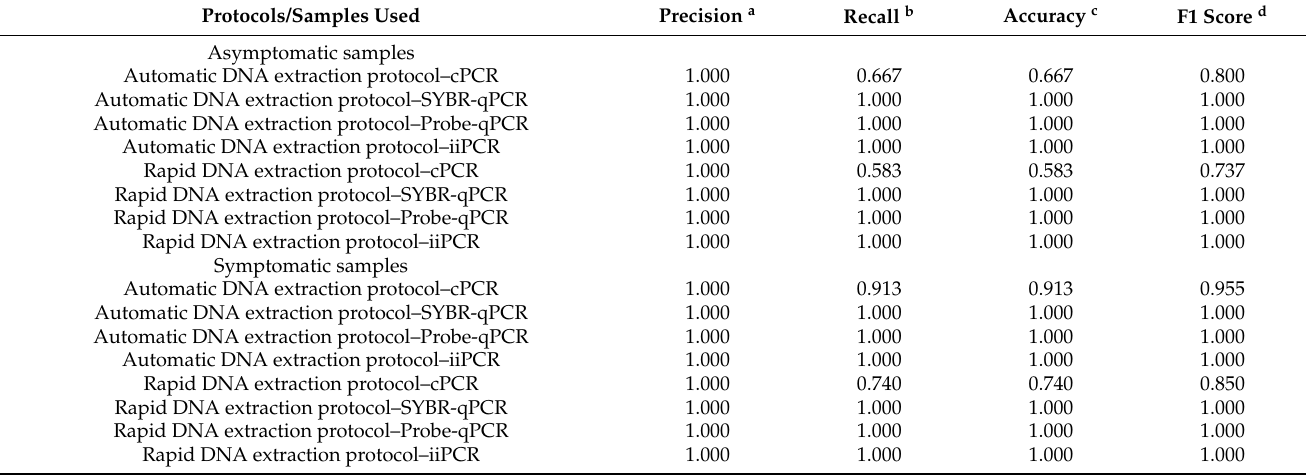
Table 10. Comparisonofthemoleculardetectionprotocolsusingasymptomaticandsymptomatic Fusarium oxysporum -infected samples extracted by automated DNA extraction or rapid DNA extraction as testers. Protocols/Samples